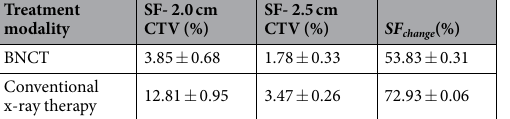
Table 3. Changes in SFs as a result of the CTV extension (from 2.0 to 2.5